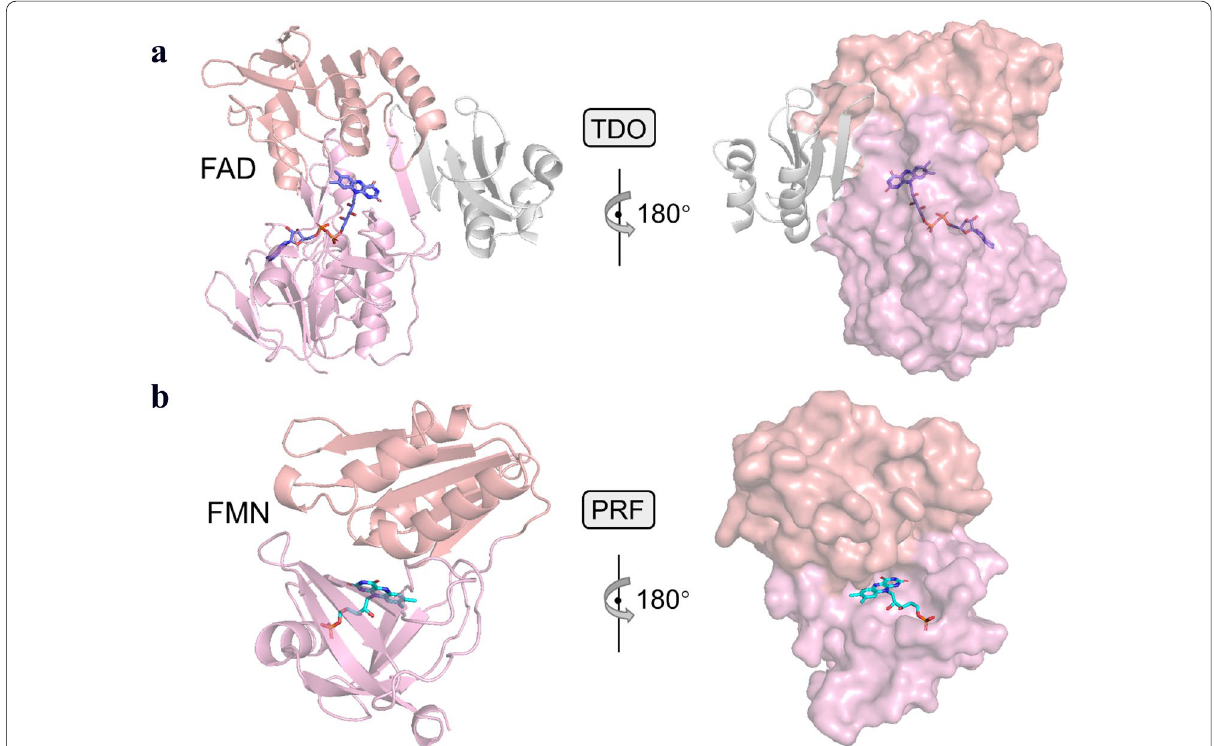
Fig. 2 Structural comparison of reductase domain of TDO and PRF. The cartoon and surface representation of the reductase domain of TDO ( a ) and PRF ( b ). NADH‑binding domain is shown in sallow and FAD/FMN‑binding domain is shown in pink, FAD and FMN are represented by